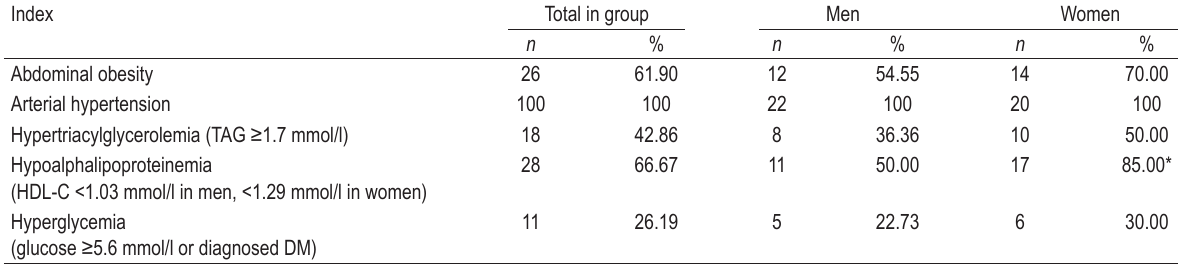
TABLE 1. Frequency of the metabolic syndrome main components in patients with arterial hypertension depending on gender